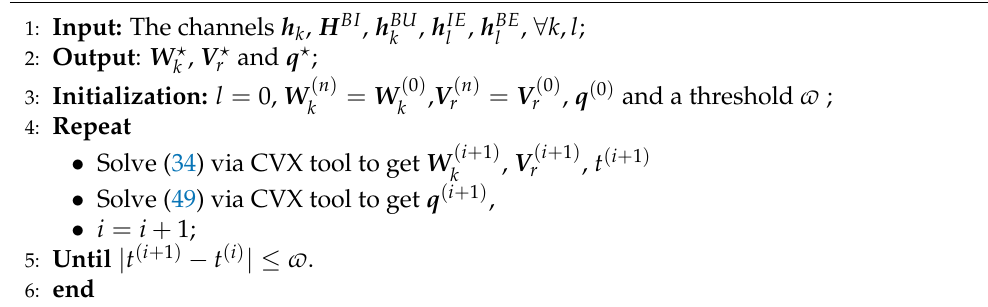
Algorithm 1 Proposed Robust Resource Allocation Algorithm